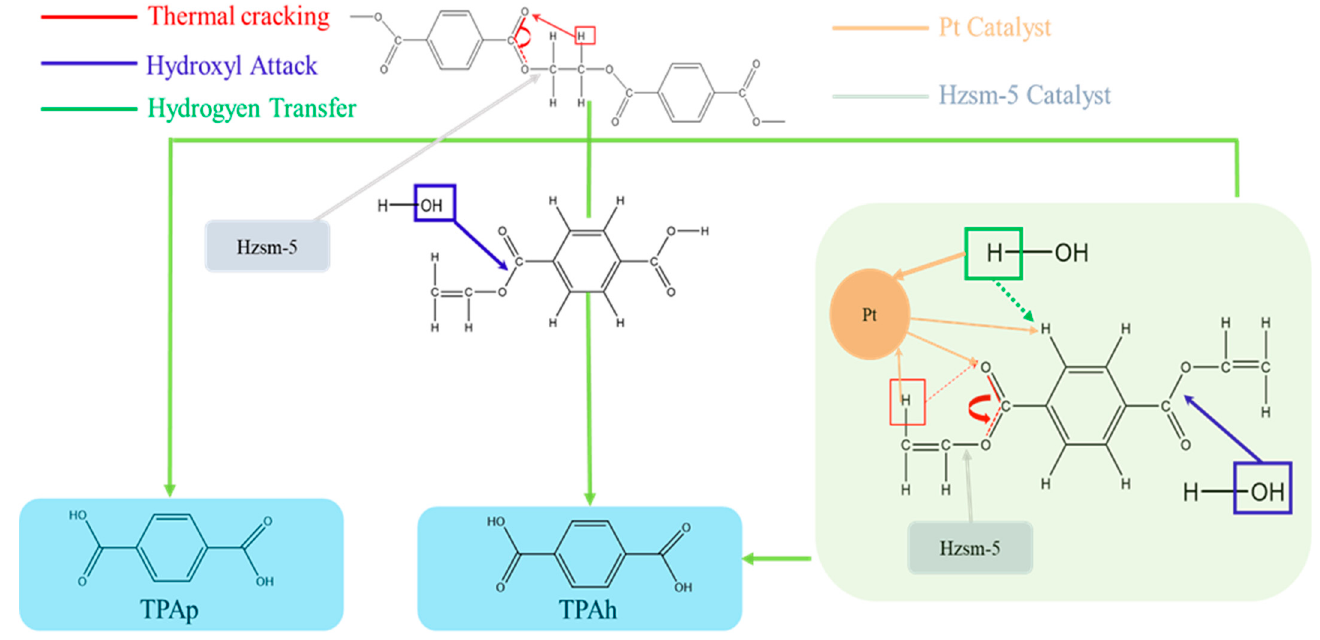
Figure 9. Reaction pathway of the Pt@Hzsm-5-catalyzed steam-assisted pyrolysis of PET.